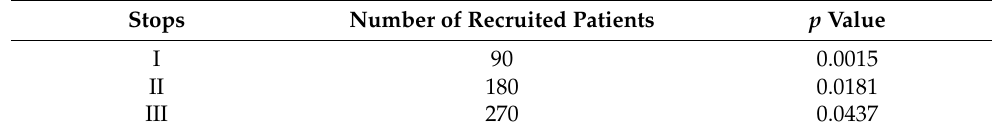
Table 4. Three stage group sequential design based on the method of O’Brien and Fleming [36].